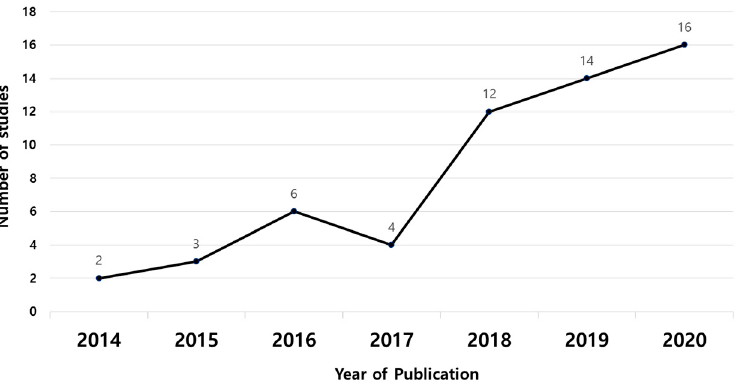
Figure 3. Publications per year. Number of articles per year between January 2014 and October 2020.